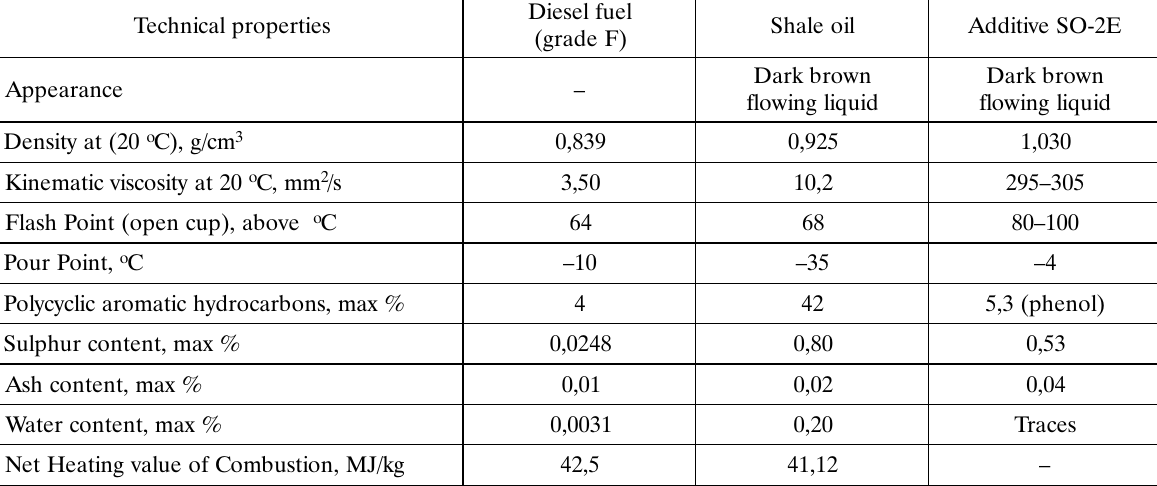
Table 1 . Properties of Diesel fuel, shale oil and additive SO-2E